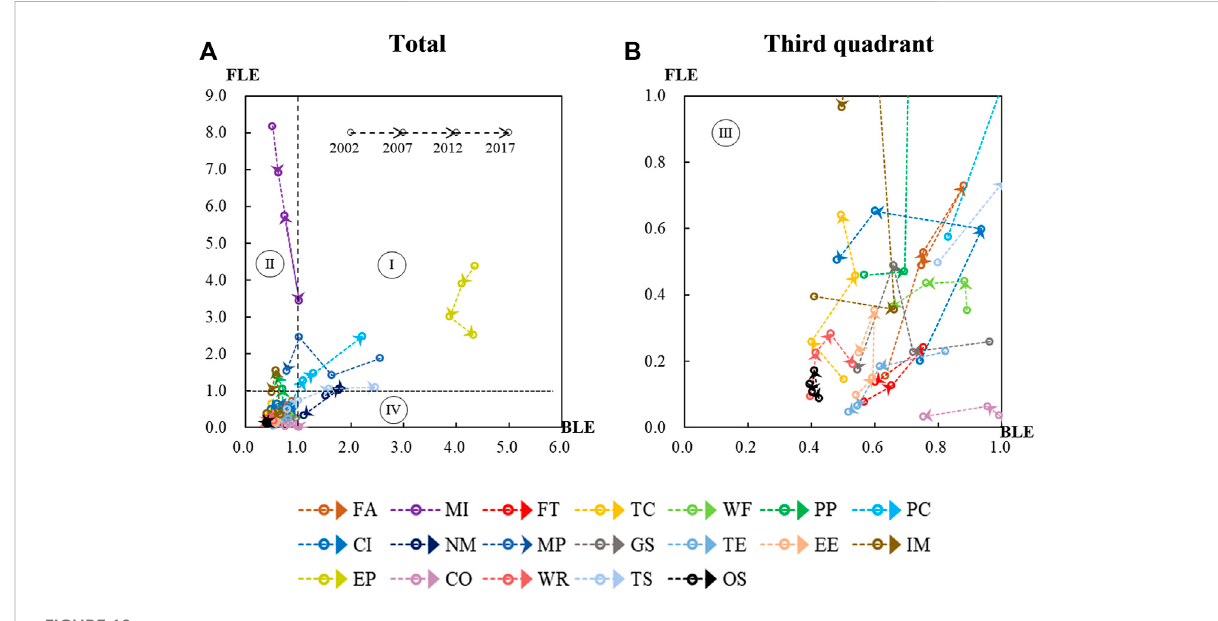
FIGURE 10 Evolutionary trajectories of various sectors during 2002 – 2017. (A) Total (B) The third